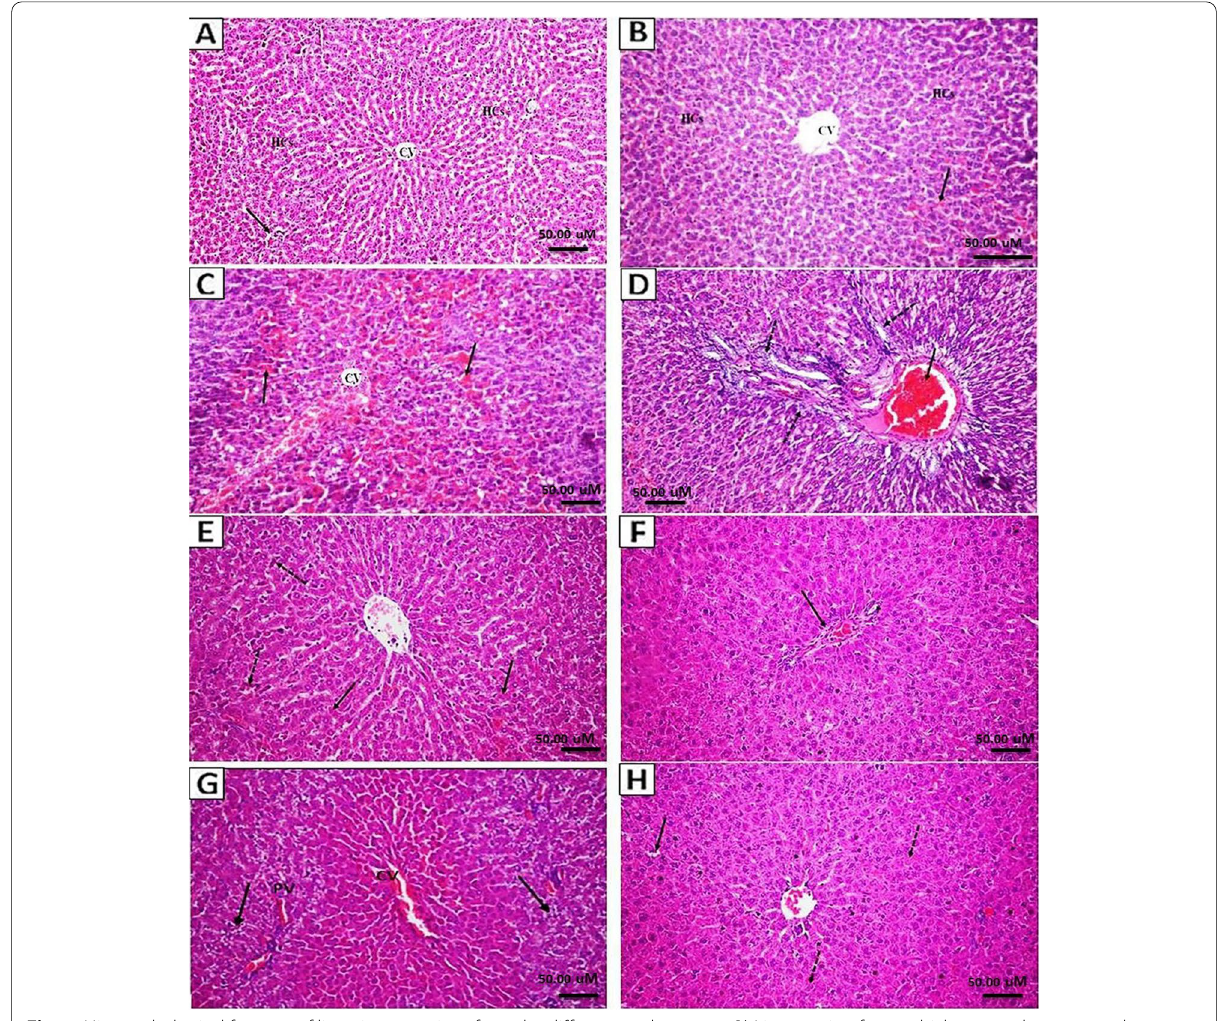
Fig. 1 Histopathological features of liver tissue sections from the different study groups. A ) Liver section from vehicle group shows normal histological structure of central vein (CV), normal hepatic parenchymal cells (HCs), and normal portal area (arrow). B ) Liver section of probiotic control reveals normal histological structure except congestion of some sinusoids (arrow). C ) and D ) Liver tissue sections from APAP‑positive control group show severe congestion of the central vein (CV), hepatic sinusoids (arrow), portal vessels congestion, multiple newly formed bile ductules (dashed arrows), and mild fibrosis (asterisk) were also detected. E ) and F ) Liver sections from APAP‑administrated group received probiotic as a prophylactic dose demonstrates mild degree of hepatocellular degenerative and necrotic changes (arrow), with some leukocytic exocytosis of the hepatic sinusoids (dashed arrow). G ) and H ) Liver sections of APAP‑administrated rat that received probiotic LGG as treatment show mild congestion of the central vein, hepatic sinusoids, and portal vessels (PV), along with moderate degree of periportal hepatocellular degeneration (arrow). H ) Hepatocellular swelling, mild scattered vacuolar degeneration (arrow), and necrosis (dashed arrow). H&E staining, magnification 200